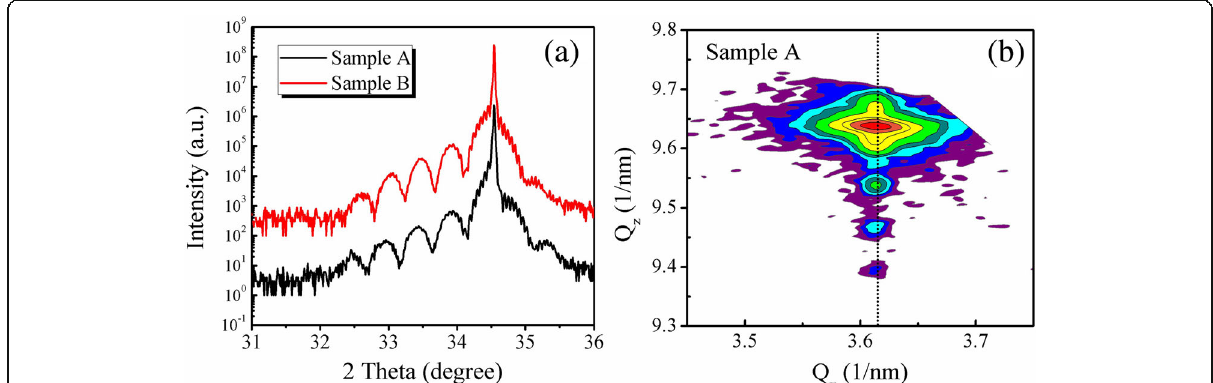
Fig. 2 Omega-2theta scans and reciprocal space mapping of both samples are performed by HRXRD. a HRXRD Omega-2theta curves on GaN (0002) plane for samples A and B. b Reciprocal space mapping (RSM) for the GaN (10 – 15) diffraction of sample A